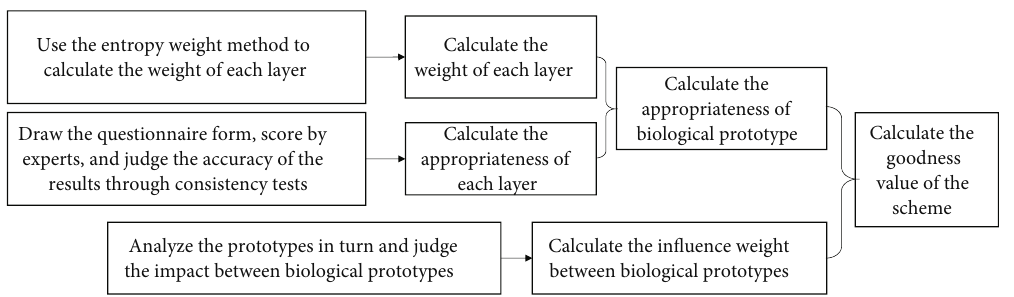
Figure 3: The scheme evaluation